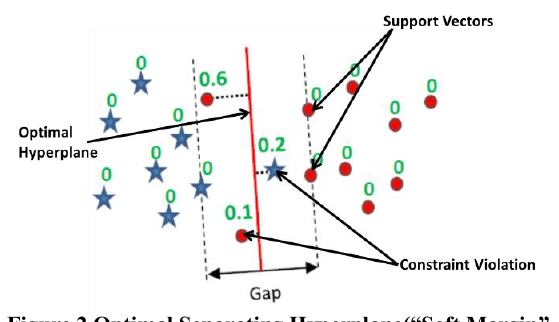
Figure 2.Optimal Separating Hyperplane(“Soft Margin”